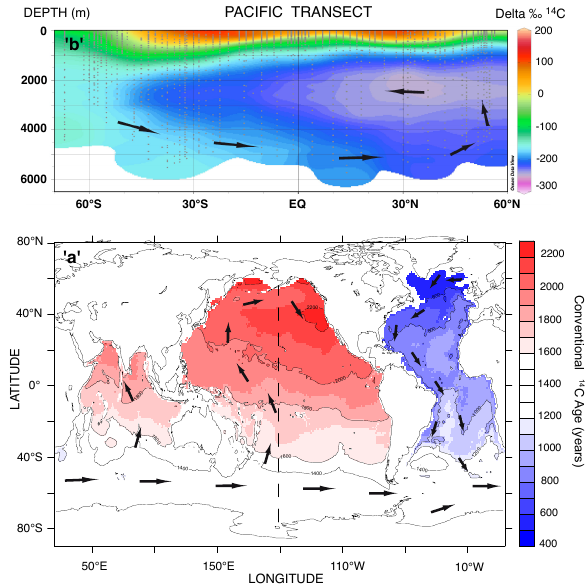
Fig. 1. Modern apparent ventilation ages based on natural radiocar- bon in the ocean below 1500mw.d. (a) (Matsumoto, 2007, modi- fied; copyright granted by J. Wiley and Sons.) Arrows indicate long- term directions of circulation. Broken line = transect position. (b) North–South transect across the Pacific at 160 ◦ W (based on GLO- DAP data; Key et al.,